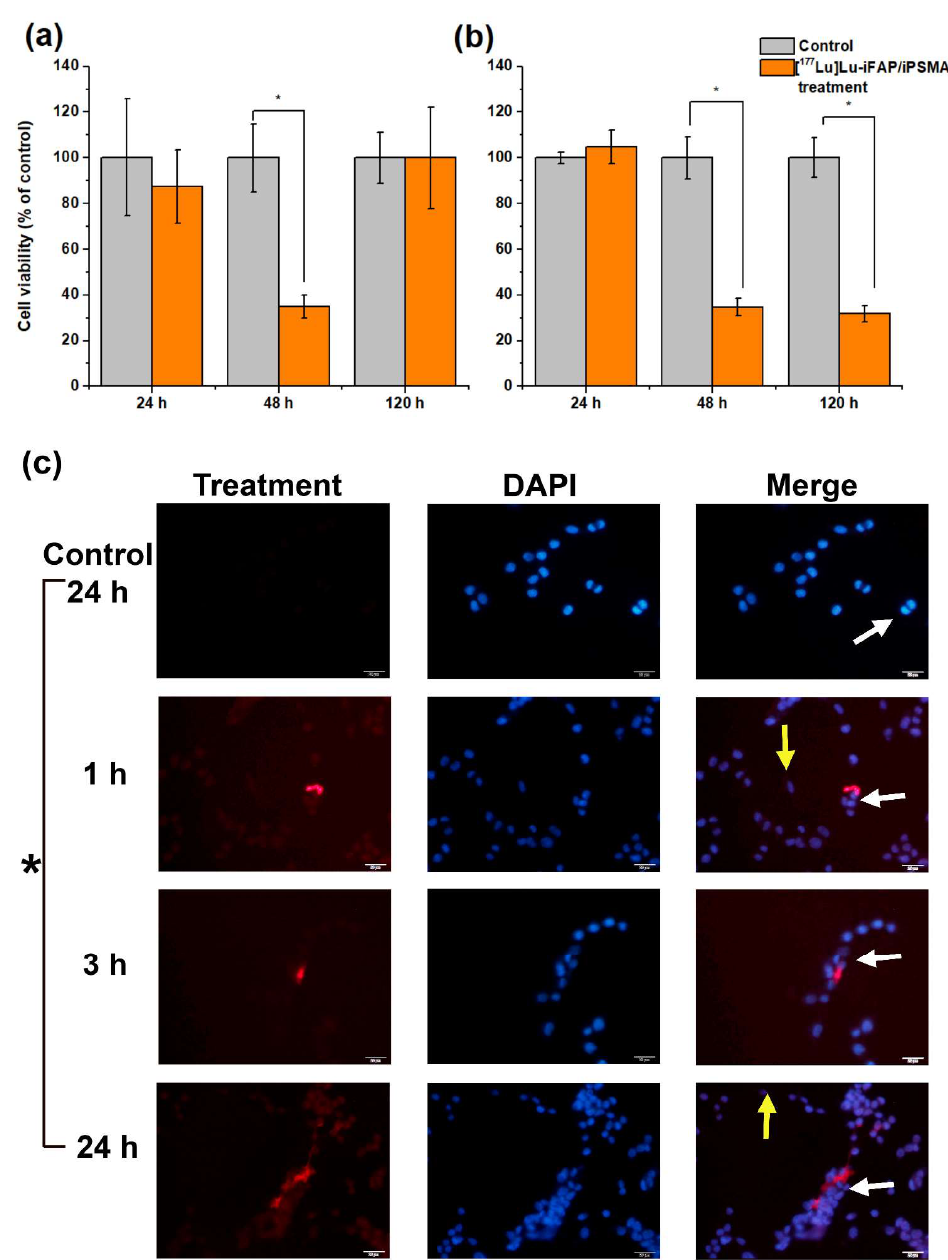
Figure 2. Cell viability of ( a ) U-937 macrophages and ( b ) HCT116 colorectal cancer cells exposed to [ 177 Lu]Lu−iFAP/iPSMA nanoparticles for 24, 48, and 120 h (orange bar). Untreated cells were considered the control group (gray bar). ( c ) Representative fluorescence micrographs (400 × ) of a coculture of colorectal cancer cells and macrophage immune cells. The coculture was treated with [ 177 Lu]Lu−iFAP/iPSMA nanoparticles for 1, 3, and 24 h. Control: cells without treatment at 24 h (red optical density of 10.95 ± 2.23). Red : emission of nanoparticles with an optical density of 29.57 ± 5.35, 34.17 ± 1.76, 79.85 ± 1.07 at 1, 3, and 24 h, respectively; Blue : DAPI (cell nuclei) and merged images. Yellow arrows point to colorectal cancer cells (tendency toward an oval shape). White arrows indicate macrophages (more prominent and more rounded than cancer cells). Of note is the significant presence of nanoparticle clusters associated with the cytoplasm of macrophages, whose accumulation increases markedly over time in parallel with macrophage proliferation. * Statistically significant difference ( p < 0.05).